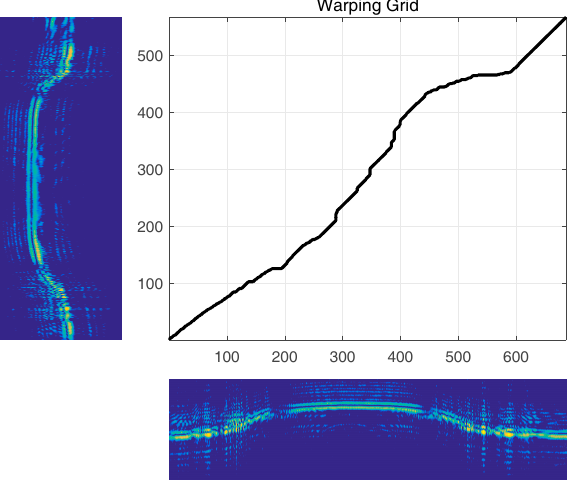
Figure 5. Warping grid using Euclidian distance.